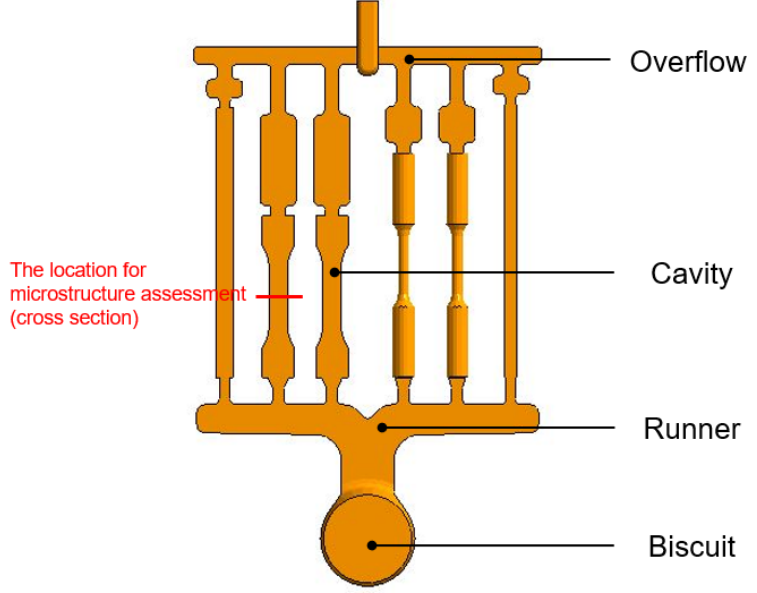
Figure 1. Schematic of the casting with gating and venting. Table 1. Chemical composition (wt.%) of the alloy used in this study.